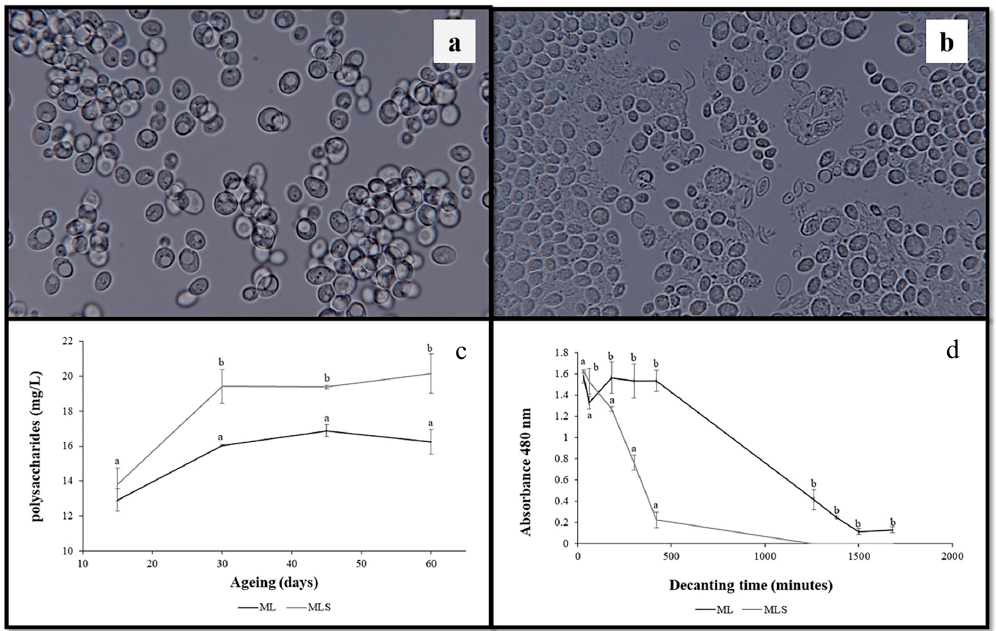
Figure 1. ( a ) Wet lees without ultrasound treatment; ( b ) wet lees after twenty minutes of ultrasound treatment; ( c ) evolution of the polysaccharides content (mg/L) in hydroalcoholic solutions, throughout the Ageing on Lees (AOL); ( d ) decanting time measured by spectrophotometry, at 480 nm (absorbance units). ML—hydroalcoholic solution with lees; MLS—hydroalcoholic solution with sonicated lees. Mean ± standard deviation of the three replicates. Different letters in axes X in figures ( c ) and ( d ) indicate values with statistical significant differences ( p <